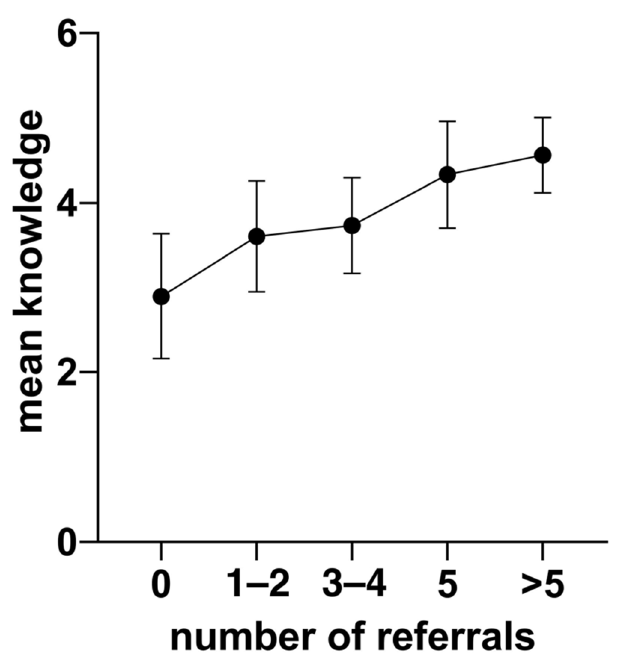
Figure 1. Knowledge about bariatric surgery significantly correlates with the number of referrals to bariatric surgery centers (r = 0.55; p <